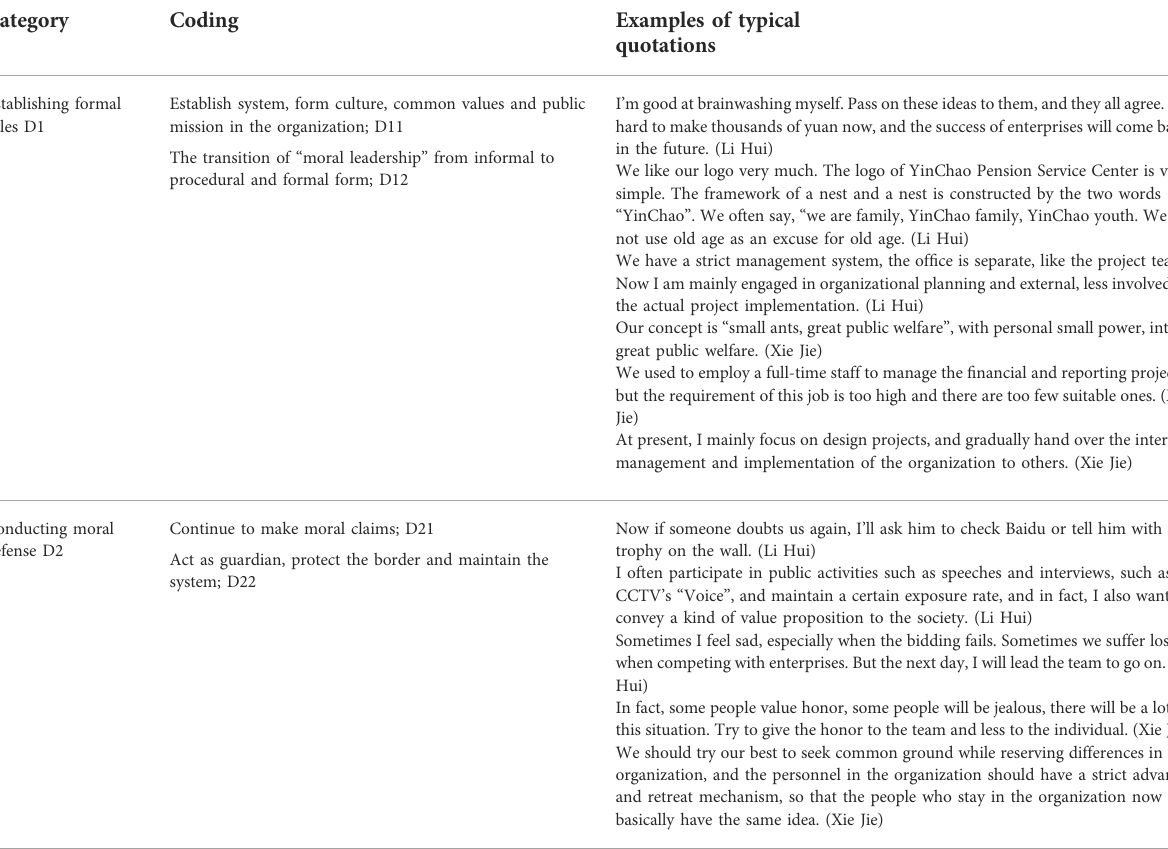
TABLE 6 Examples of typical statements and related categories in the stage of rule